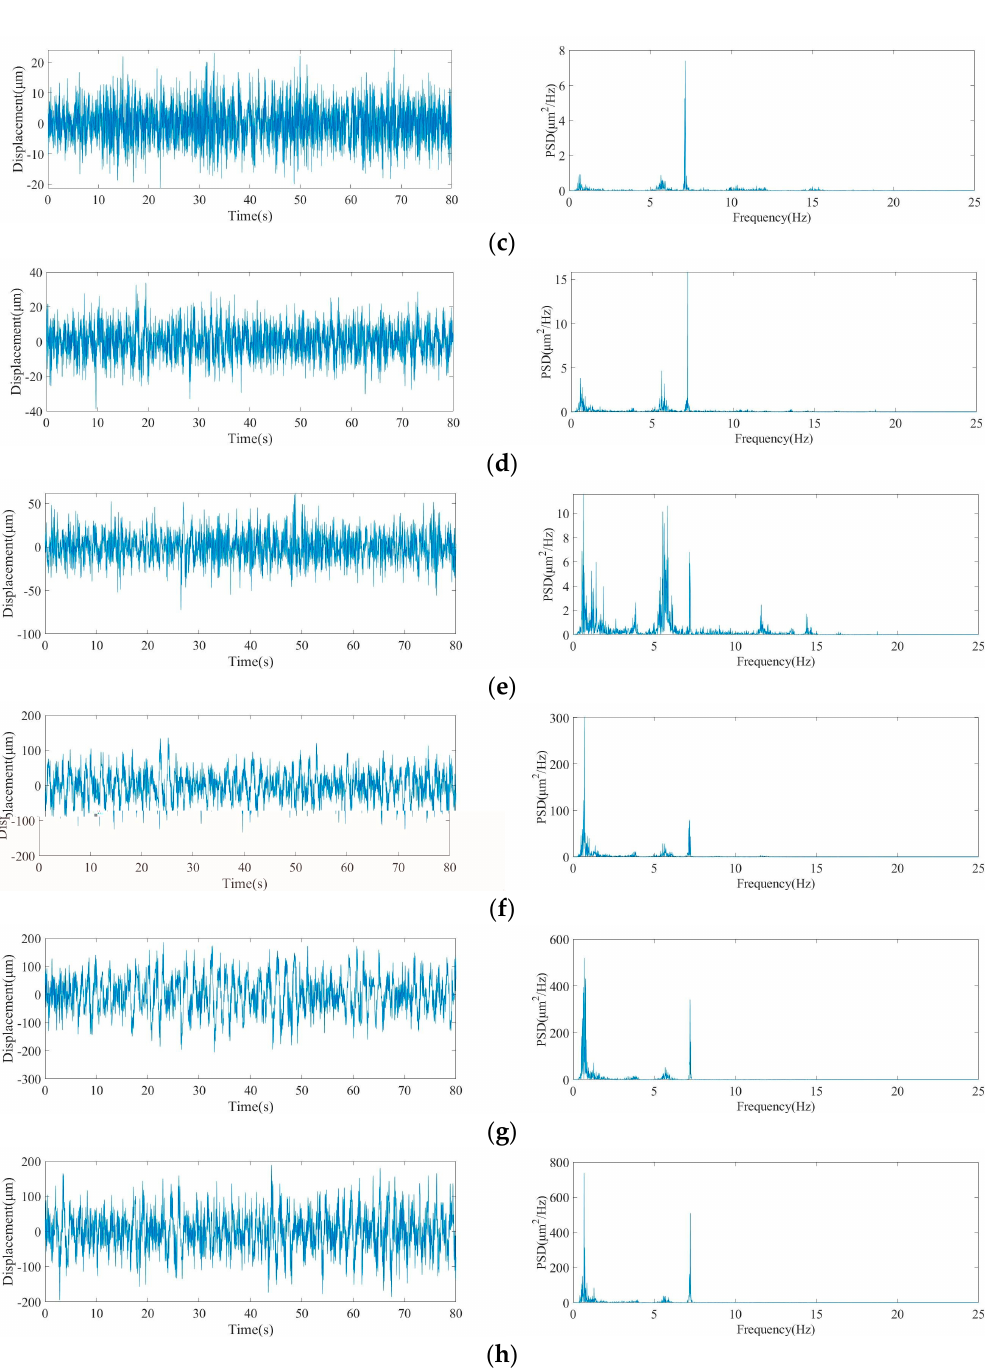
Figure A2. The time-history and FT spectrum of horizontal displacement in guide wall blocks. ( a ) 1# guide wall block; ( b ) 2# guide wall block; ( c ) 3# guide wall block; ( d ) 4# guide wall block; ( e ) 5# guide wall block; ( f ) 6# guide wall block; ( g ) 7# guide wall block; ( h ) 8# guide wall block.